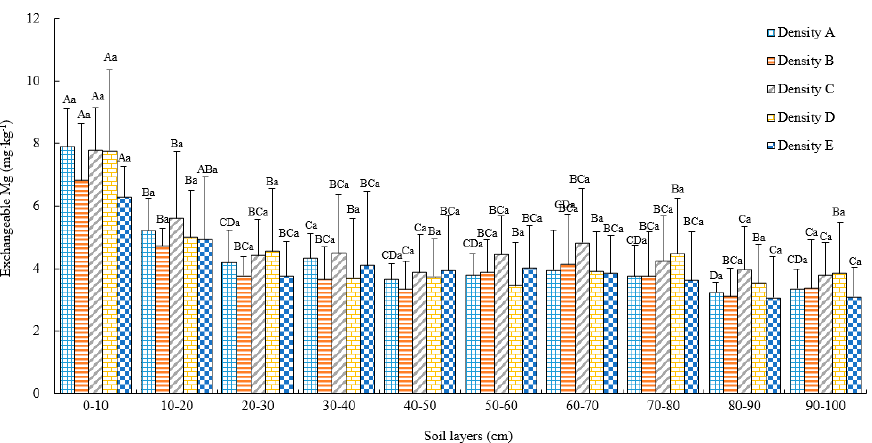
Figure 10. Soil exchangeable Mg in di ff erent layers under di ff erent stand densities (g · kg − 1 ). Note: di ff erent lowercase letters indicate significant di ff erences among di ff erent densities at the 0.05 level, and di ff erent capital letters of the same density indicate significant di ff erences among di ff erent soil layers at the 0.05 level.